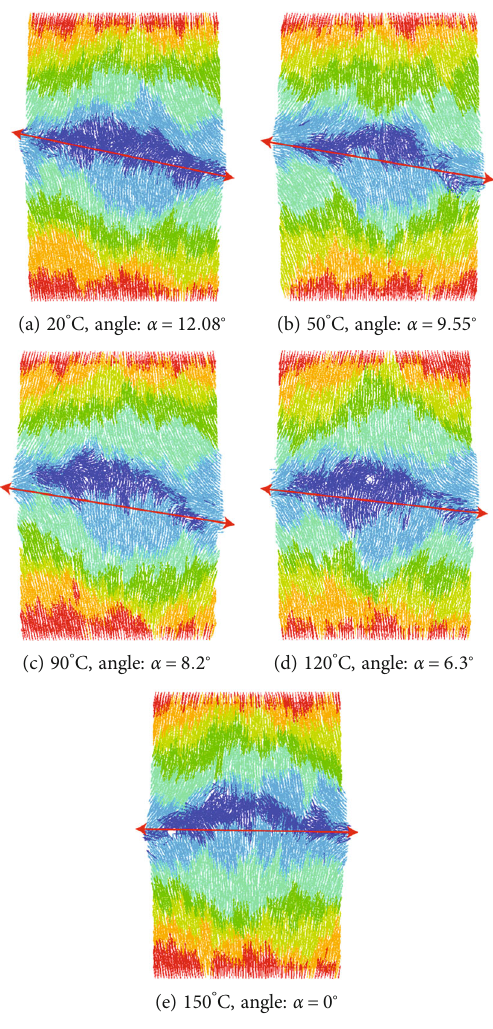
Figure 9: Displacement fi eld nephograms of sample model at di ff erent